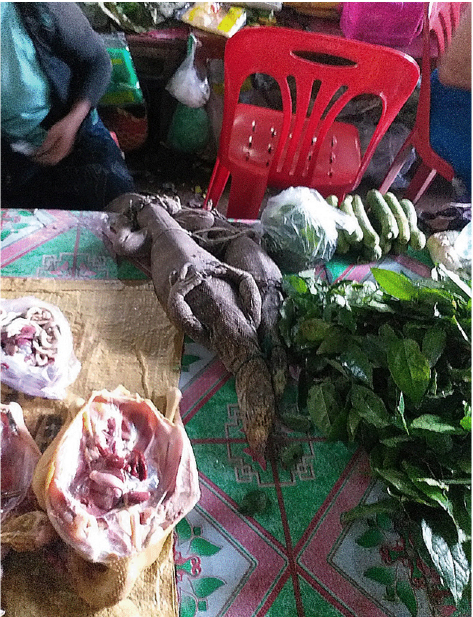
Figure 1. Live monitor lizard sold at a local wet market in the Lao